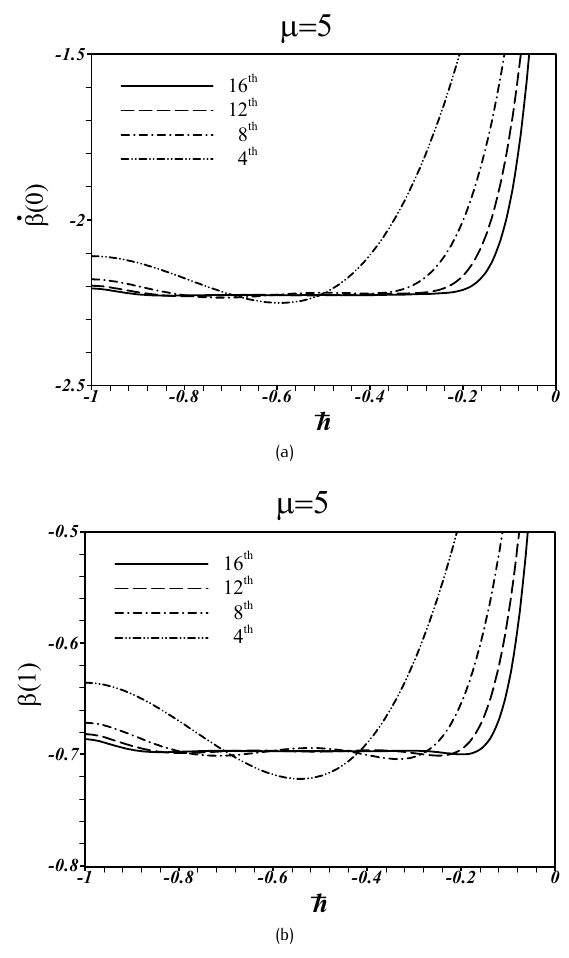
Figure 2. Comparison of convergence for different orders, µ = 5 , (a) ˙ β (0) , (b) β (1) . Fig.2. Comparison of convergence for different orders, µ=5, (a) vertical and horizontal deflection ( x ( L ) ,y ( L )) and slope are presented. It is clear that by increasing the weight dimen-